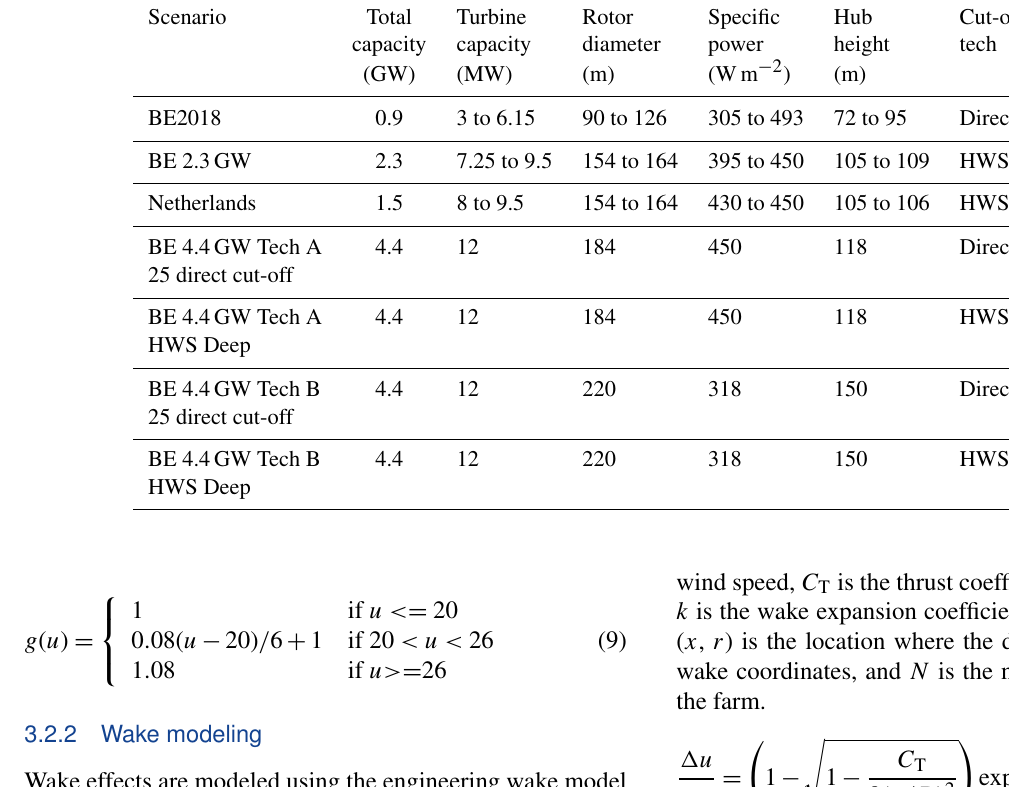
Figure 3. Plant and turbine locations for the different stages of offshore wind installations. Table 1. Plant and turbine characteristics for the different stages of offshore wind installations. Characteristics are given for the added turbines with respect to the previous stage of installation except for total capacity. The Dutch plants are taken into account when modeling external wake impacts on the Belgian fleet. Note that the actual turbines and plant layouts for the BE2018, BE 2.3GW, and Netherlands scenarios were